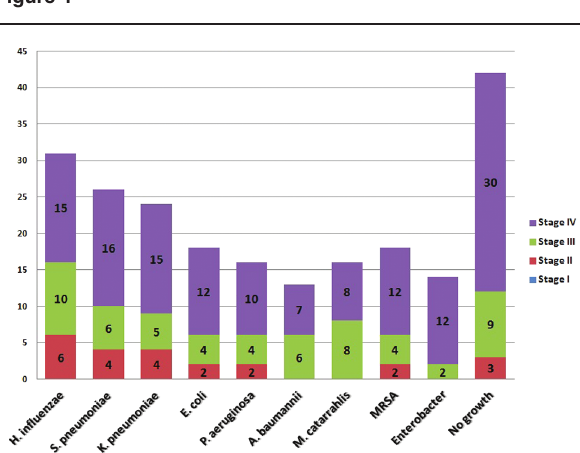
Bacterial strains detected during 218 exacerbation attacks in different COPD stages. Each number of bacterial-positive samples is repre- sented both with a bar and absolute values in the abscissa. No bacterial isolates were detected in 42 attacks. A. baumannii , Acinetobacter baumannii ; E. coli , Escherichia coli ; H. influenzae , Haemophilus influenzae ; K. pneumoniae , Klebsiella pneumoniae ; M. catarrahlis , Moraxella catarrhalis ; MRSA, methicillin-resistant Staphylococcus aureus ; P. aeruginosa , Pseudomonas aeruginosa ; S. pneumoniae , Streptococcus